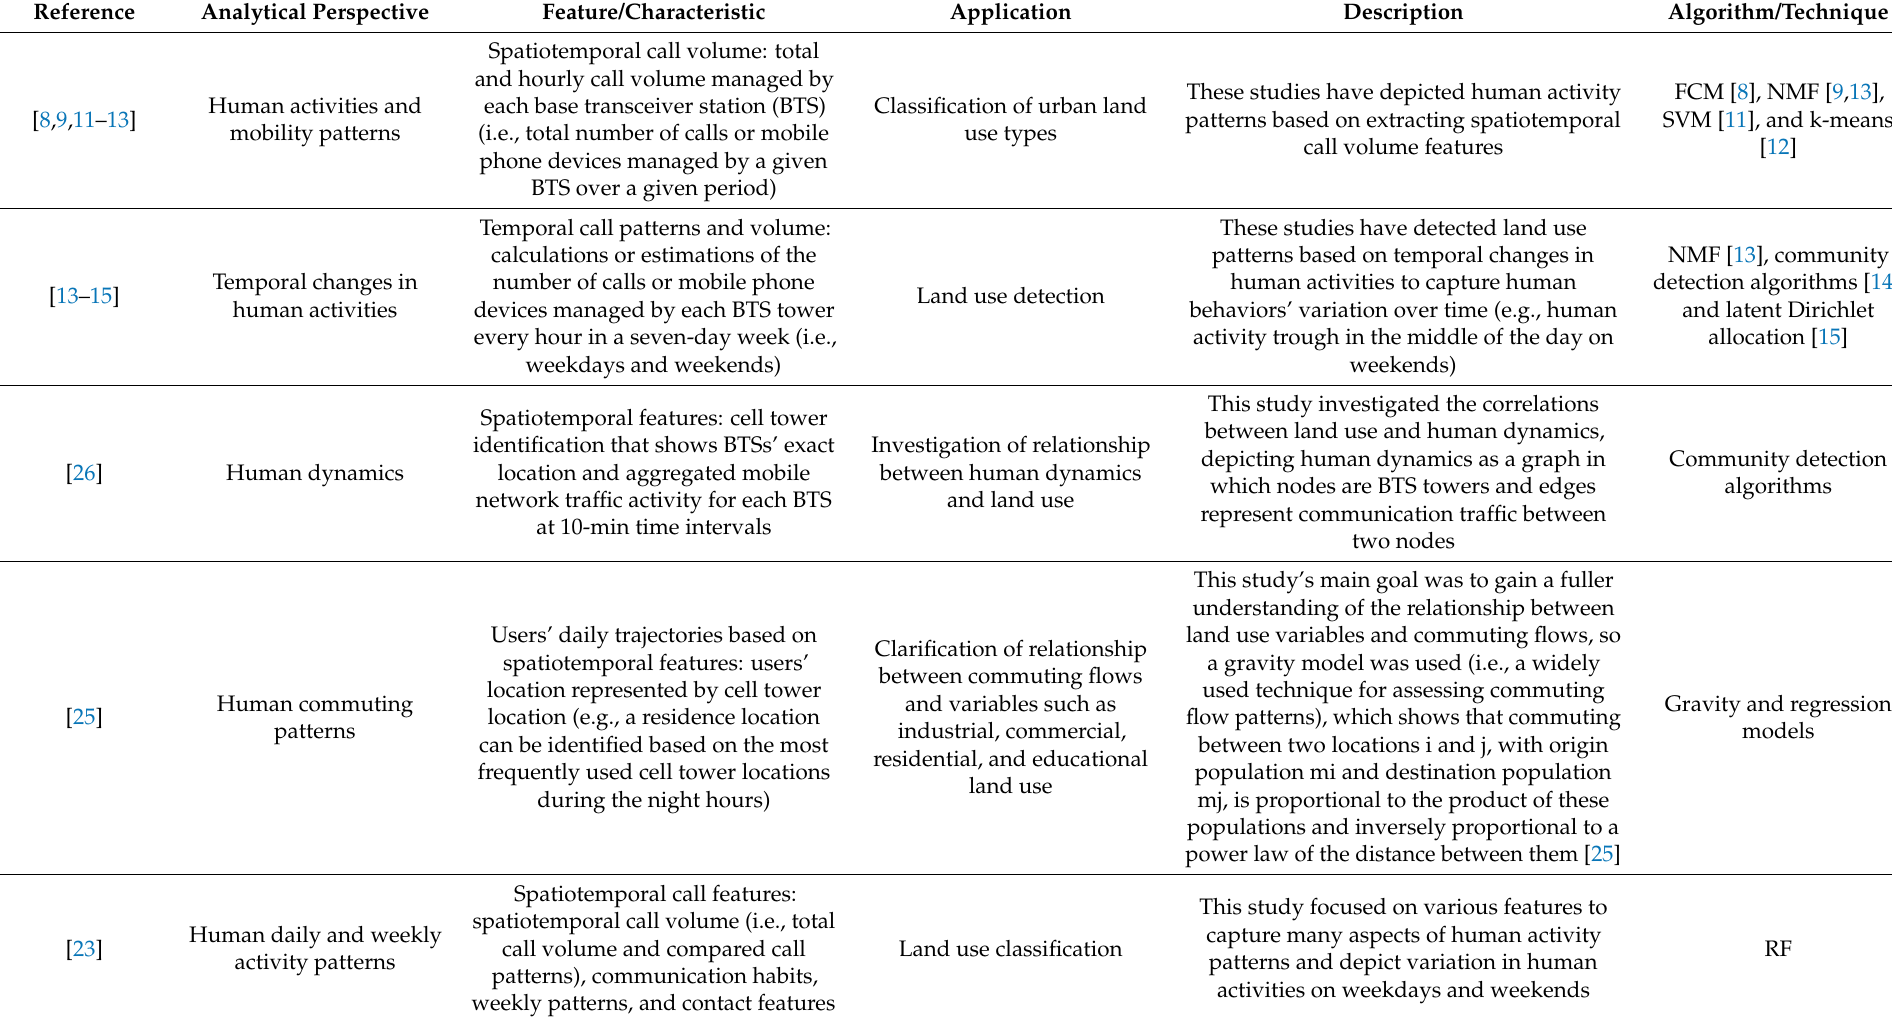
Table 1. Prior research on human activities and land use based on mobile phone